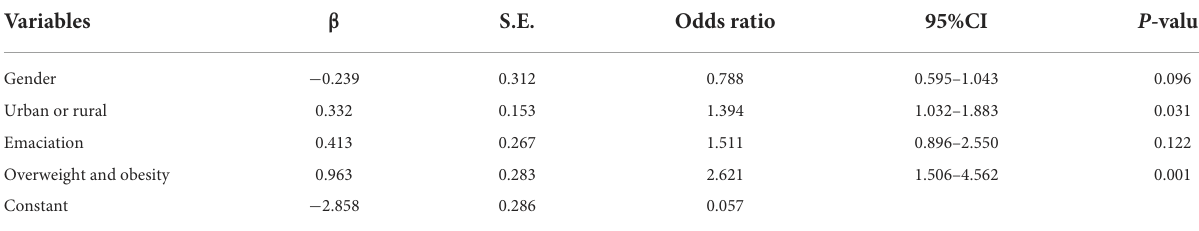
TABLE 4 Multivariate analysis with logistic